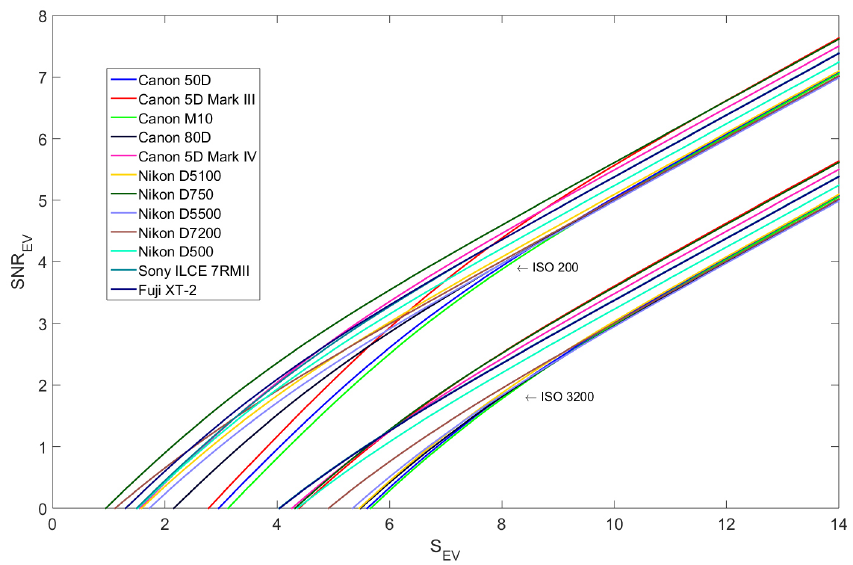
Figure 12. Pixel SNR vs. RAW value for ISO 200 (top) and 3200